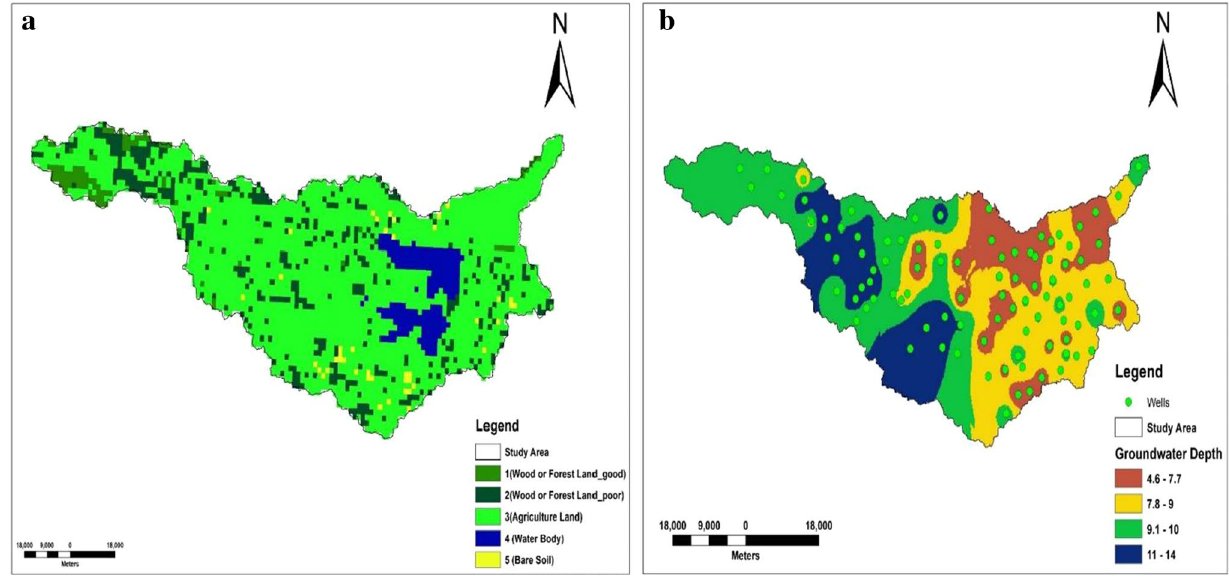
Fig. 4 a LULC map, and b groundwater depth